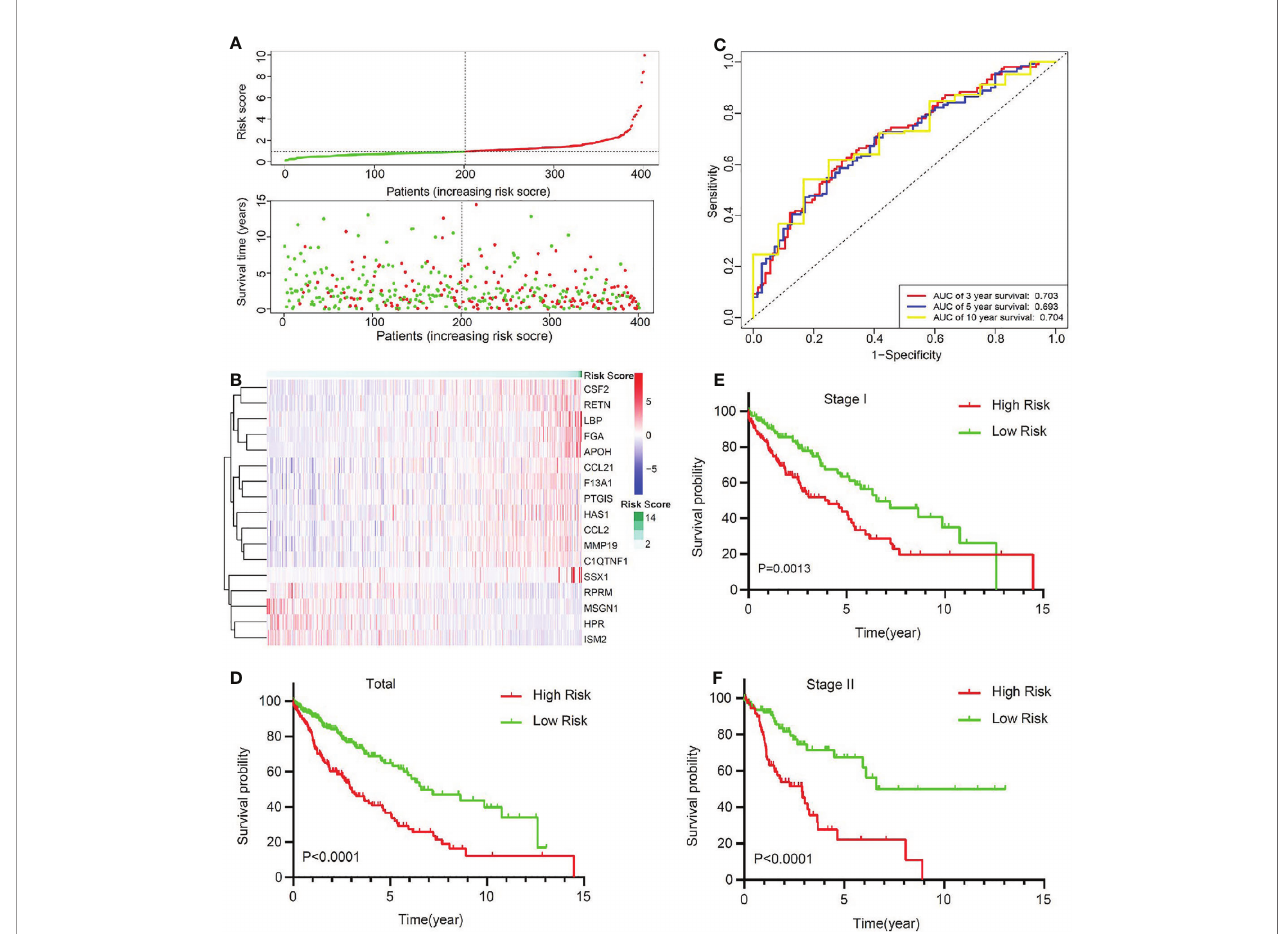
FIGURE 3 | The signature of key prognostic immune-related genes and their potential predictive value in early stage LUSC based on a TCGA training set. (A) The distribution of risk score and survival status. (B) Distribution of speci fi c gene expression based on risk score. (C) ROC curves of these key genes to predict death risk at 3, 5, and 10 years in TCGA set. (D) Comparison of overall survival of all patients with early stage LUSC between high risk and low risk. (E, F) Kaplan – Meier curves of patients with stage I and stage II LUSC based on risk